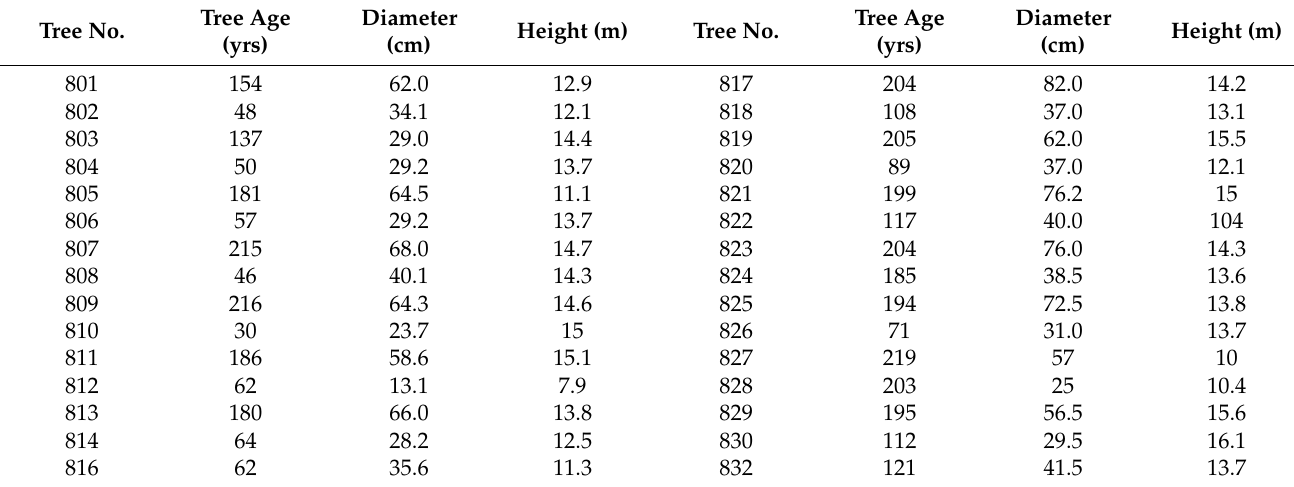
Table 1. Dasometric Characteristics of the Selected